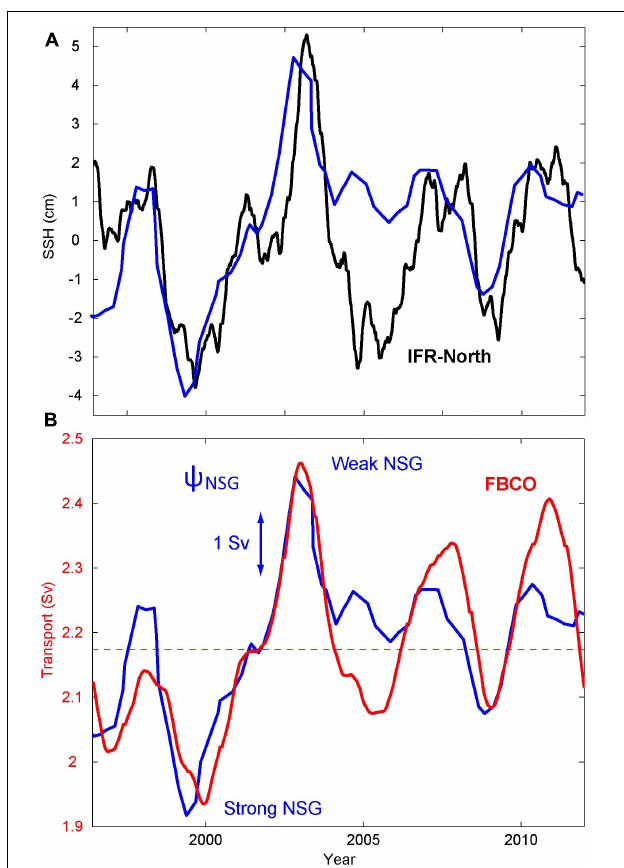
FIGURE 7 | Time series of the baroclinic NSG rim transport ψ NSG (blue), compared to (A) sea-surface height north of the Iceland-Faroe ridge (IFR-North, black), and (B) the FBCO transport (red). ψ NSG is here estimated using representative depth and width of D = 2 km and W = 30 km, respectively ( Table 3 ). ψ NSG is not an absolute measure of transport (therefore no values are provided on the y -axis), and the magnitude of inter-annual changes is illustrated by the blue double arrow in (B)